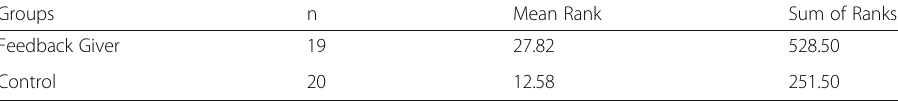
Table 10 Feedback giver group and control group ranks in the picture description task Groups